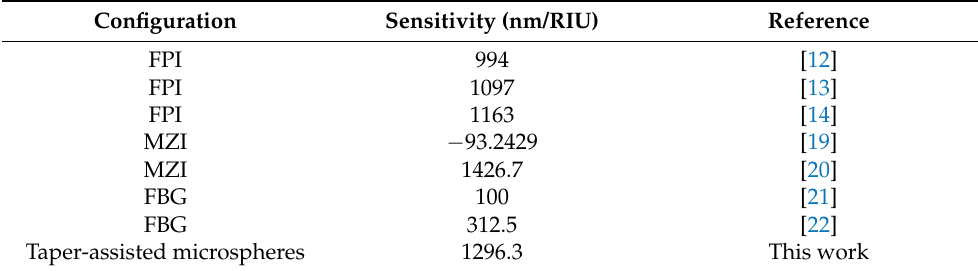
Figure 9. ( a ) The transmission spectrum shift of taper-assisted 4-spheres-loop sensor as increasing n 0 . ( b ) The wavelength shifts with different D 3,4 versus the changes of surrounding RI. ( c ) The sensitivity comparison of 4-spheres-loop sensor under different D 3,4 . Table 1. Comparison of the sensing performance of the fiber-optic refractometric sensors.